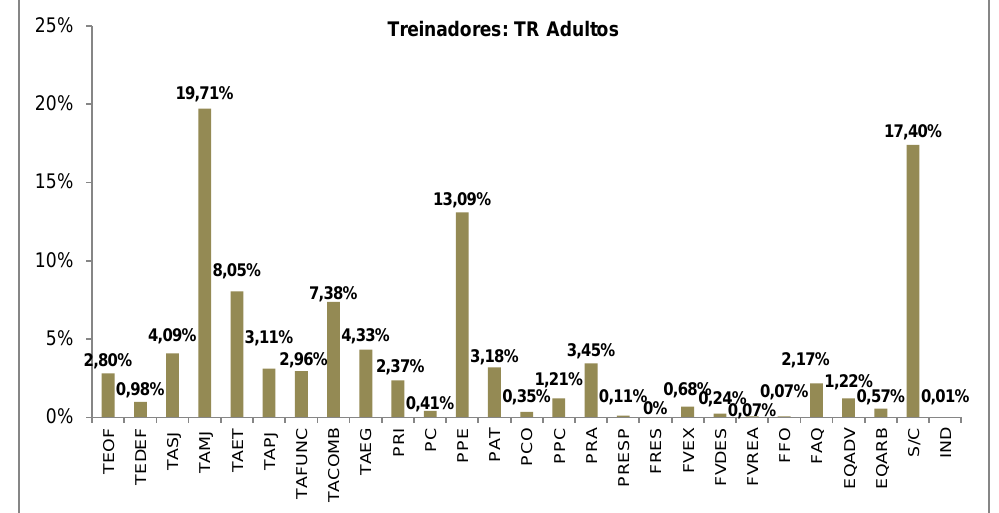
Figura 6. Valores em porcentagem das categorias/subcategorias da dimensão conteúdo durante a competição (TEOF